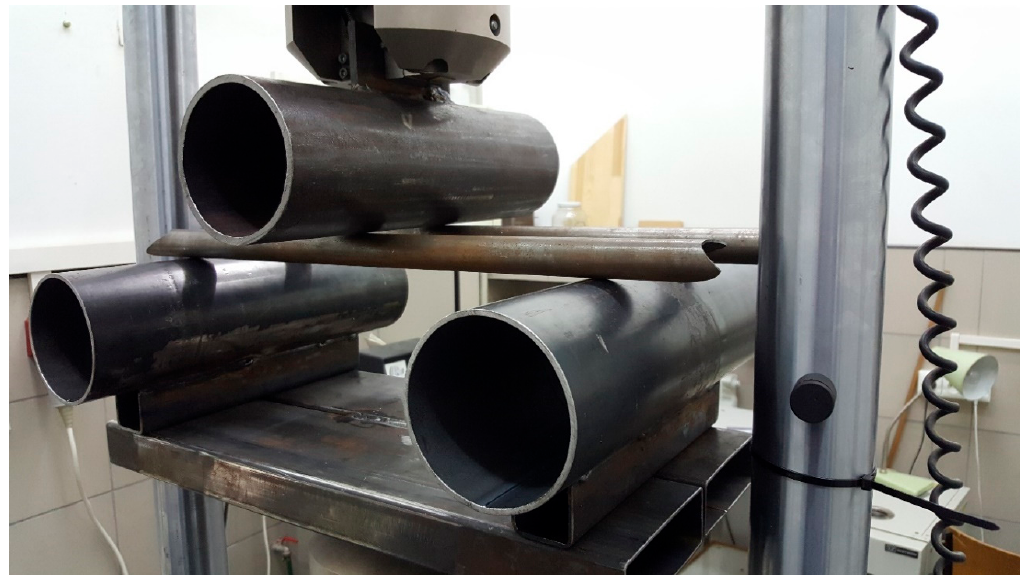
Figure 3. Steel tubes test setup .